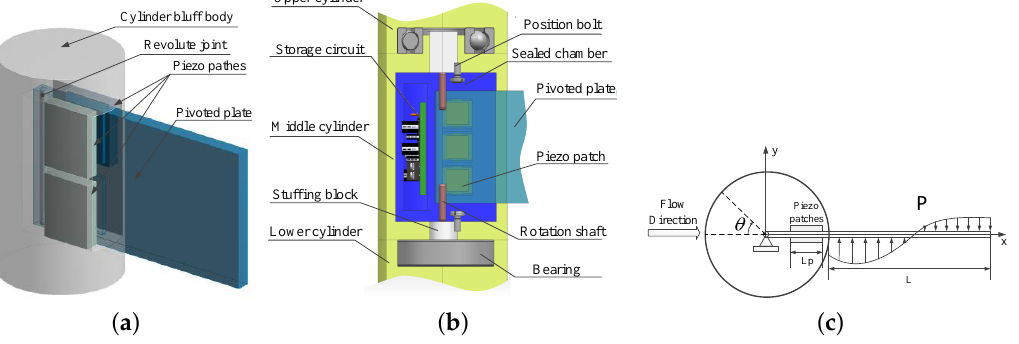
Figure 1. Components of the vortex-induced piezoelectric energy converter (VIPEC): ( a ) a general view, ( b ) an inside view and ( c ) a principle diagram of the simplified two-dimensional